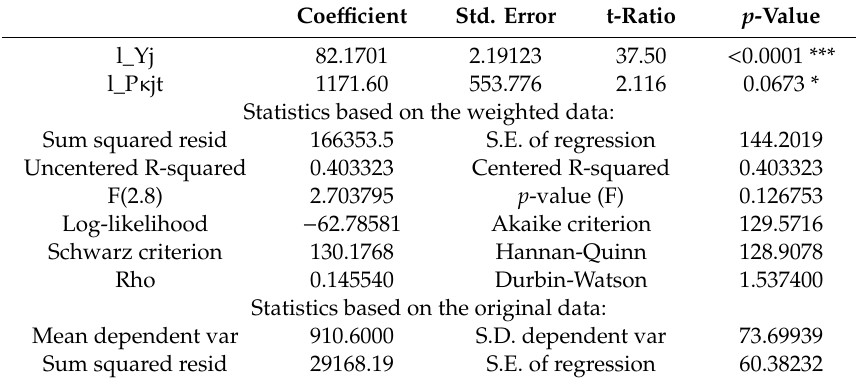
Table 5. FGLS estimation of the total amount of Croatian tourists in the Hungary—final model. Model 2: FGLS, using observations 2009–2018 (T = 10); dependent variable: TAij; variable used as weight: